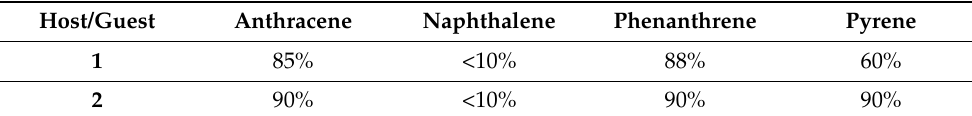
Table 2. Maximum variations (quenching) on the emission intensity of the host 1 or 2 in the titration with PAHs.